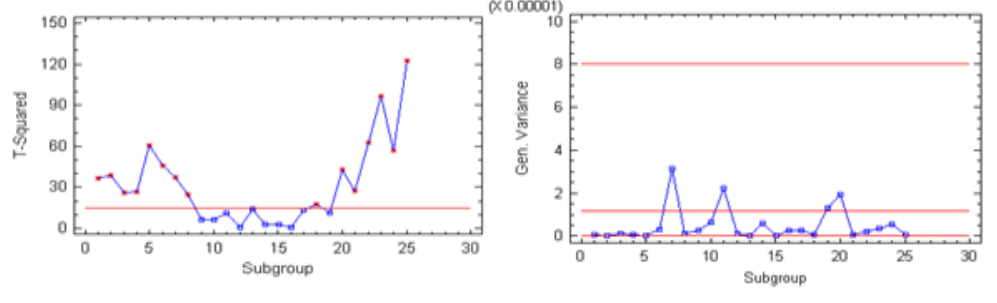
Figures 39 & 40. “T 2 control chart for the primary data” & “Generalized chart for the primary data”.